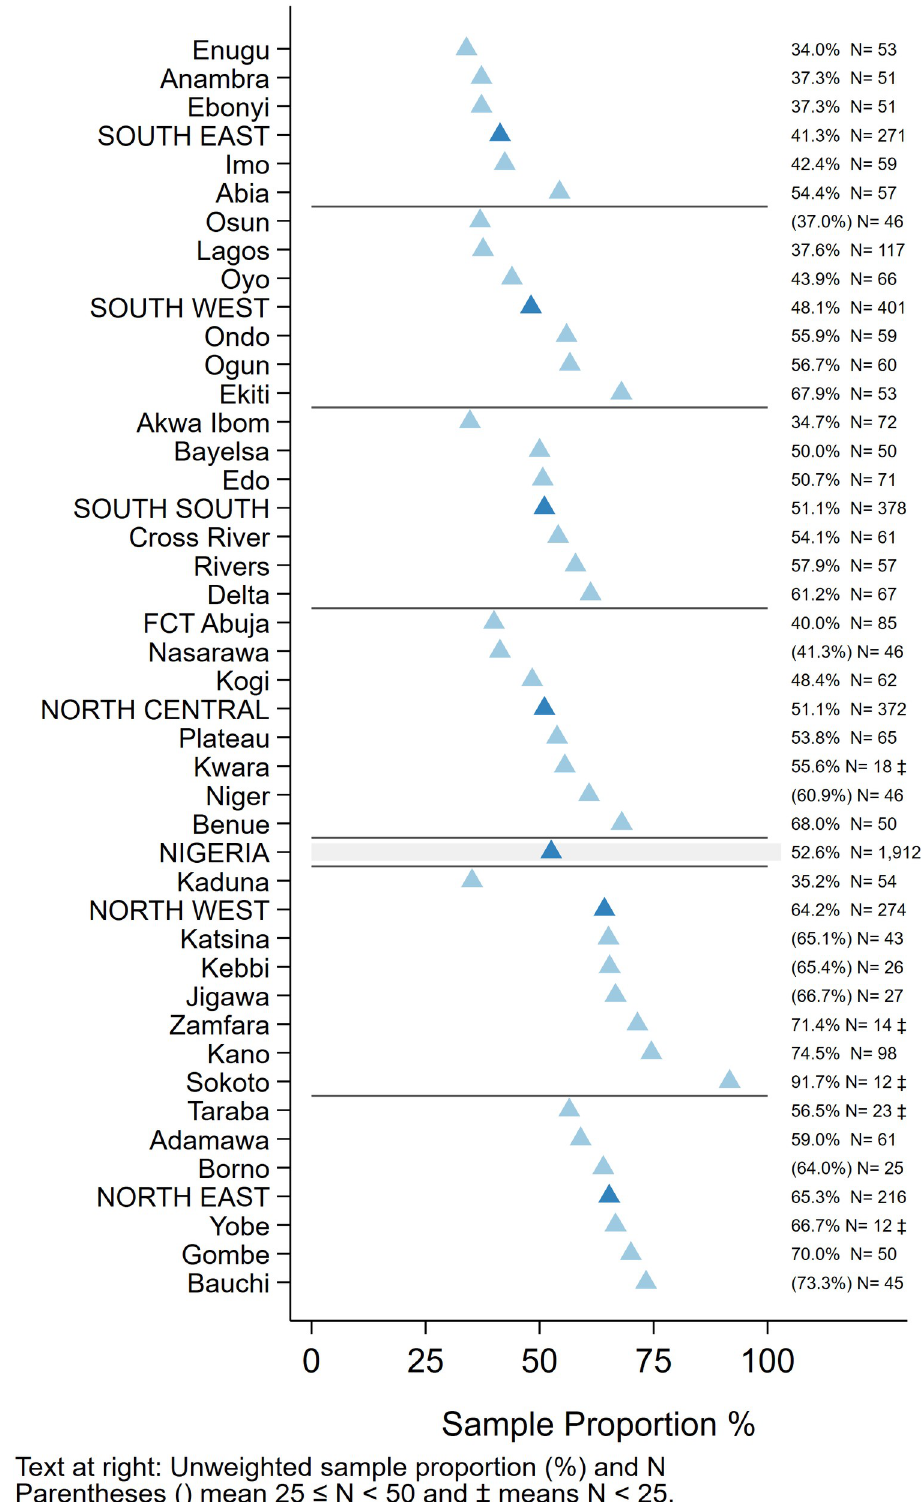
Fig 7. Unweighted percentage of children aged 12–23 months with a HBR who had at least one MOV for BCG, HBV0, OPV0-3, Penta1-3, MCV or YF due to non-simultaneous vaccination, by state, Nigeria MICS/NICS 2016–